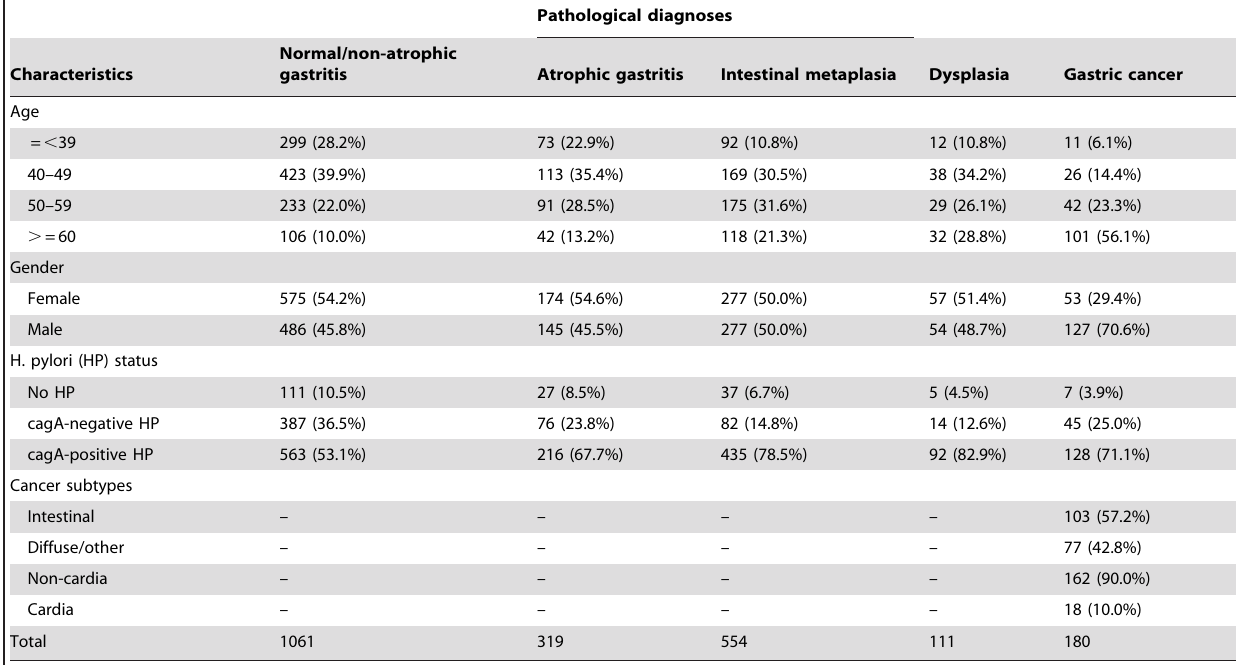
Table 1. Characteristics of study